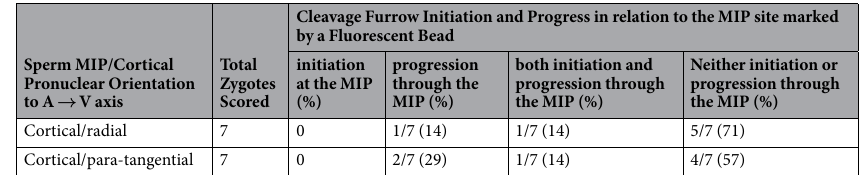
Table 3. NHP Zygotes Do Not Initiate or Progress the Cleavage Furrow through the ICSI Microinjection Point